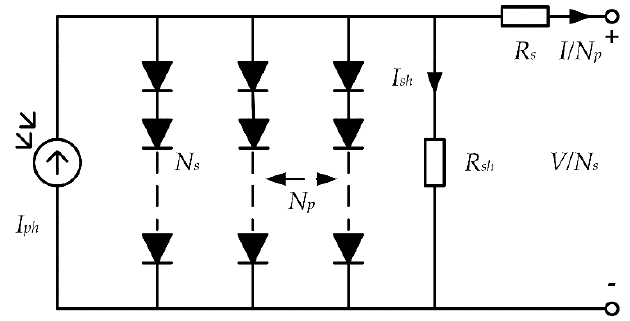
Figure 3. Equivalent circuit of PV module model.